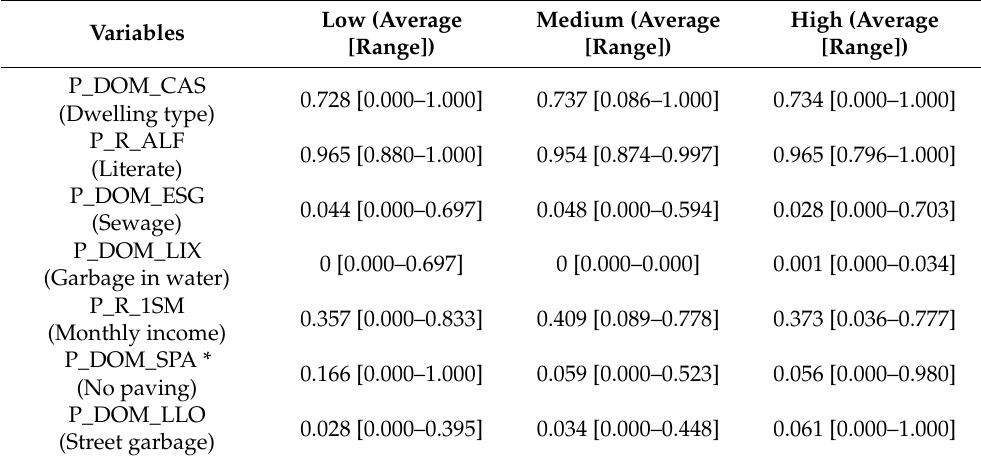
Table 2. Statistical summary of the classification of each kernel density according to socioeconomic